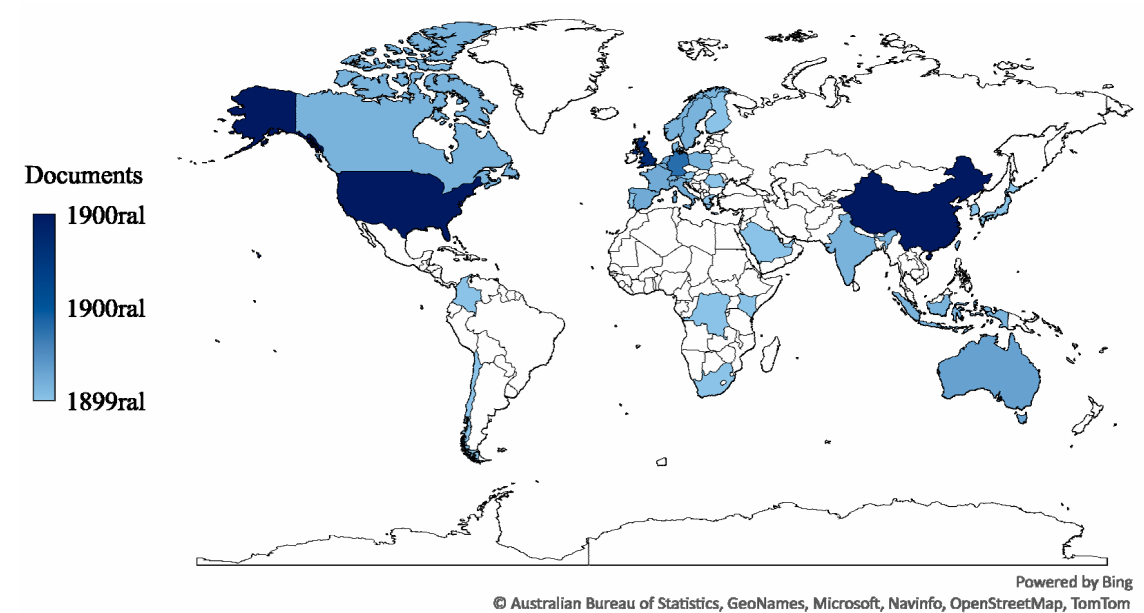
Figure 5. Number of publications by country. (Chart produced in Microsoft Excel).